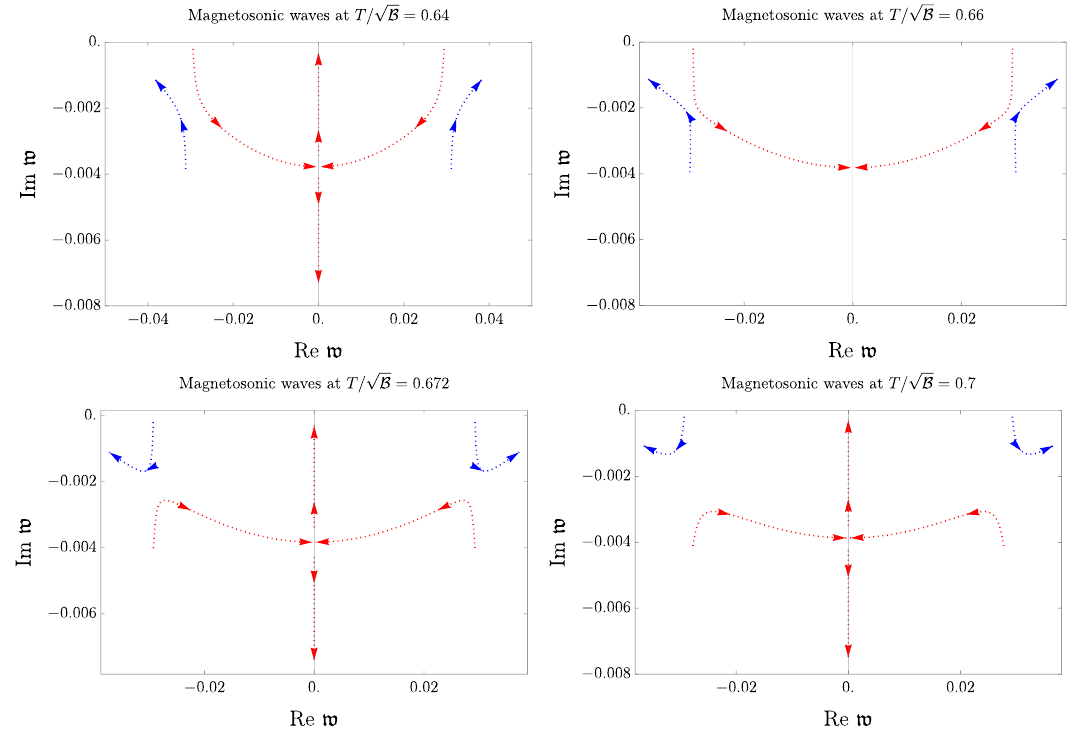
p B of fast (blue) and p B = 0 :